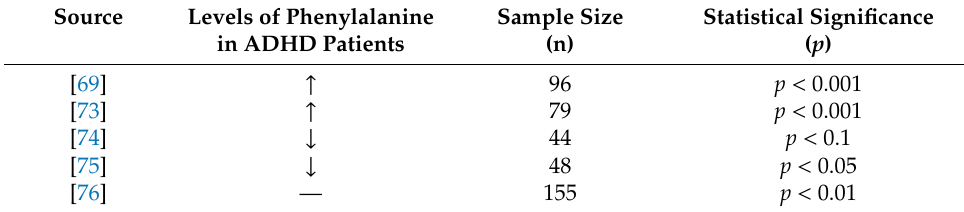
Table 1. Various studies that tested phenylalanine levels in ADHD patients. ↑ represent the increase of phenylalanine found in ADHD patients and ↓ the decrease of the amino acid in comparison to healthy controls (HC). The symbol — describes that the study found no correlation between ADHD and phenylalanine levels. The accumulative data to date do not allow a definite correlation between a change in phenylalanine levels and ADHD. p levels less than 0.05 were considered statistically different.